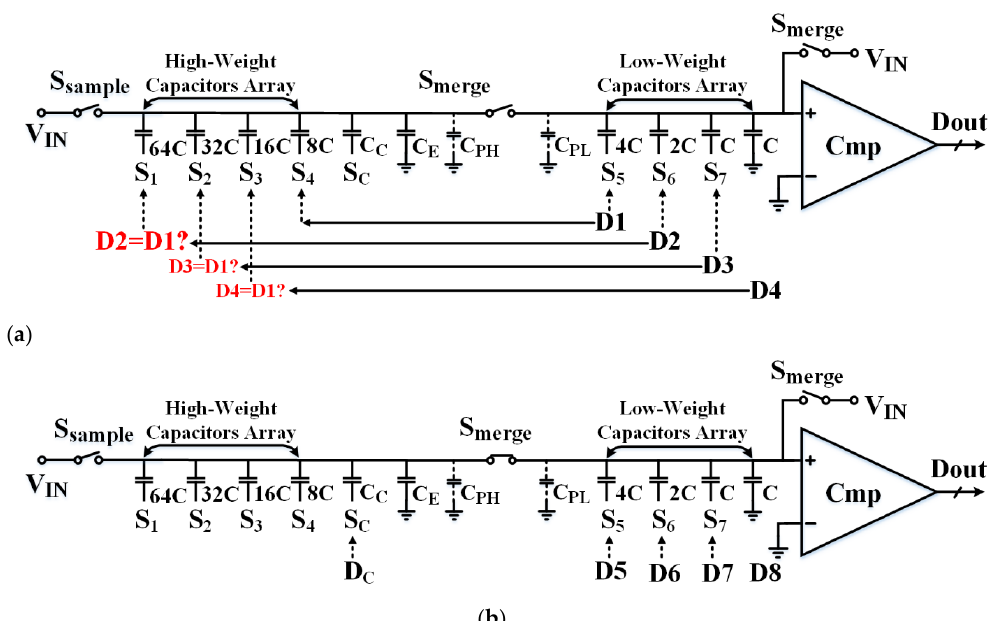
Figure 6. ( a ) Pre-quantization stage, and ( b ) global quantization stage in segmented pre-quantization and bypass switching scheme.